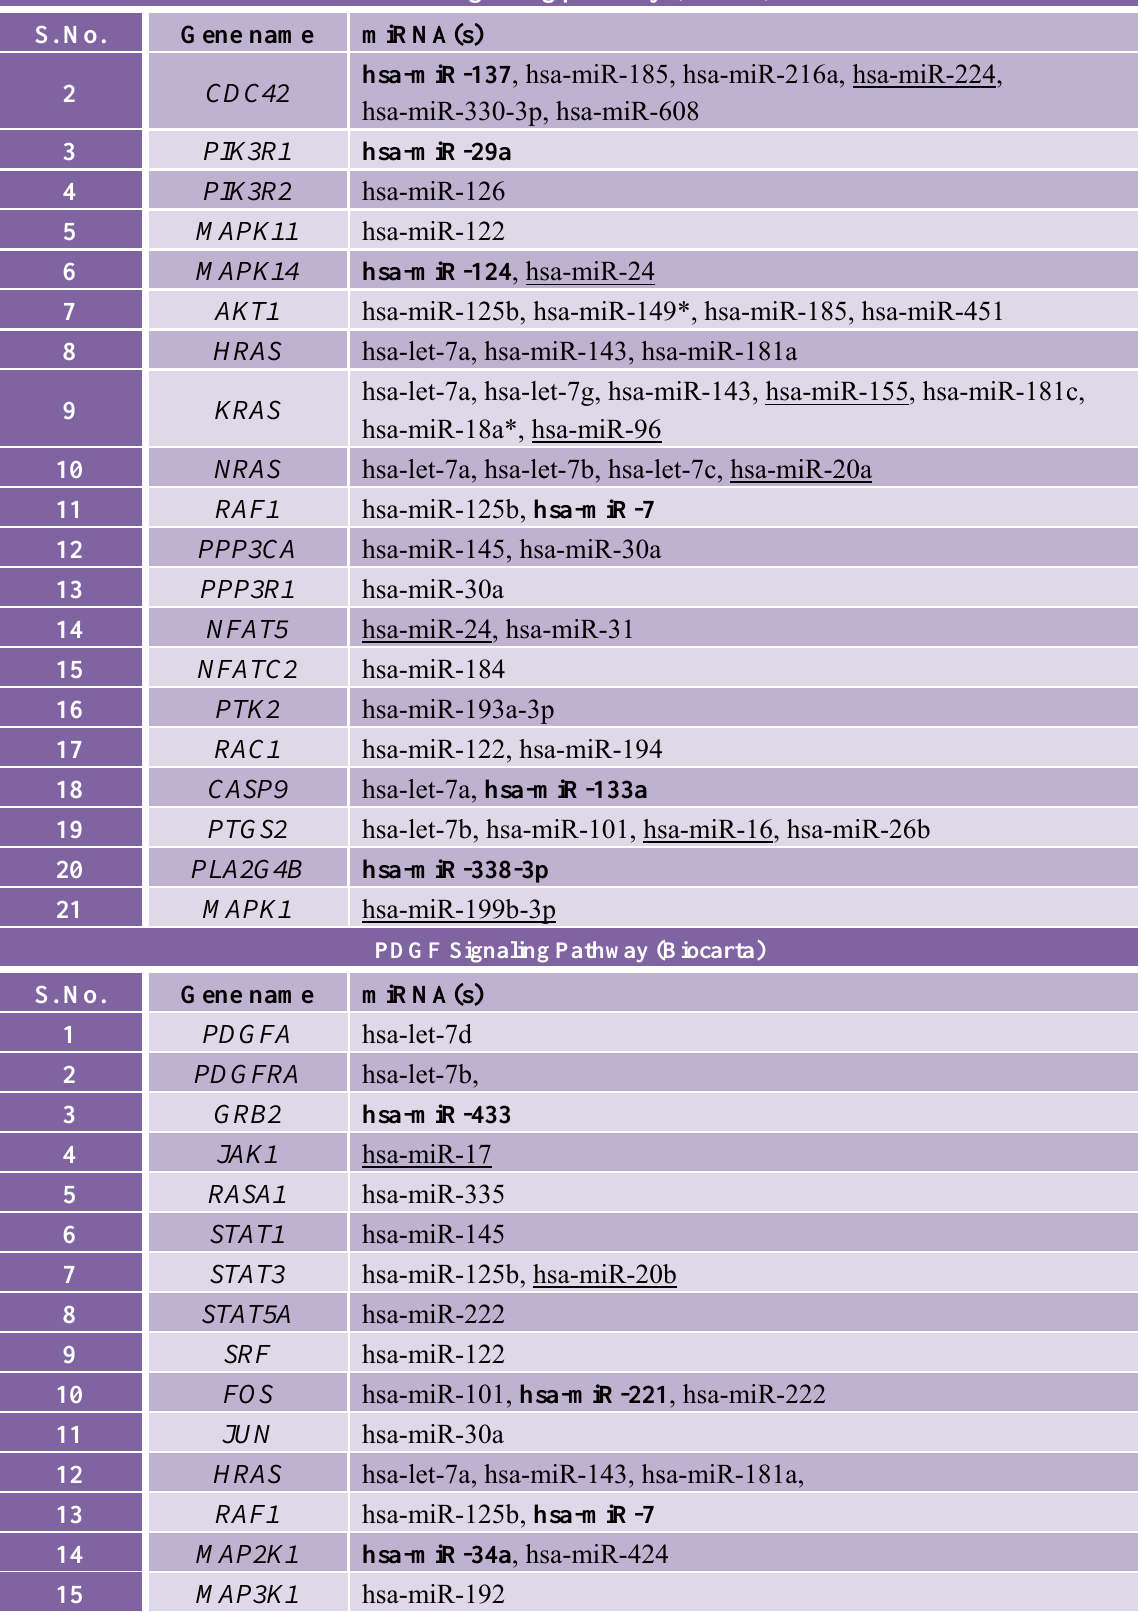
Table 2. Cont . VEGF signaling pathway